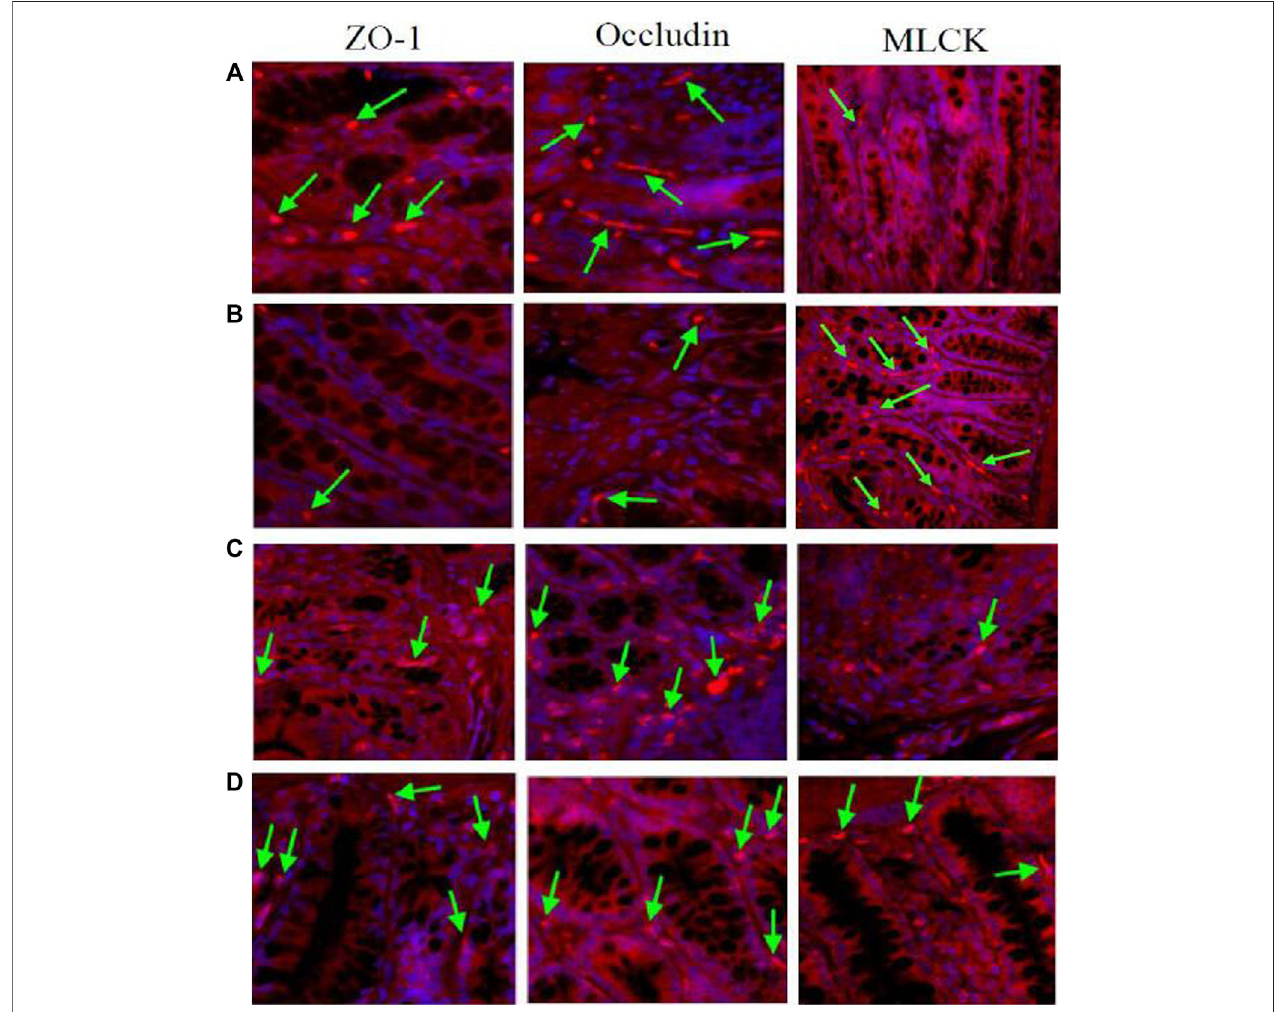
FIGURE8| The expression ofTJ proteins (Occludin and ZO-1) and MLCK in therats colon.The arrows indicated theTJ proteins or MLCK [ (A) : normal; (B) model; (C) multiple dose of WJW in normal; (D) multiple dose of WJW in model].